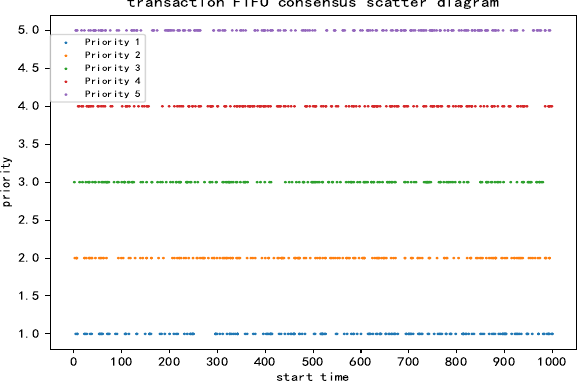
Figure 6. FIFO way transaction scatter diagram.